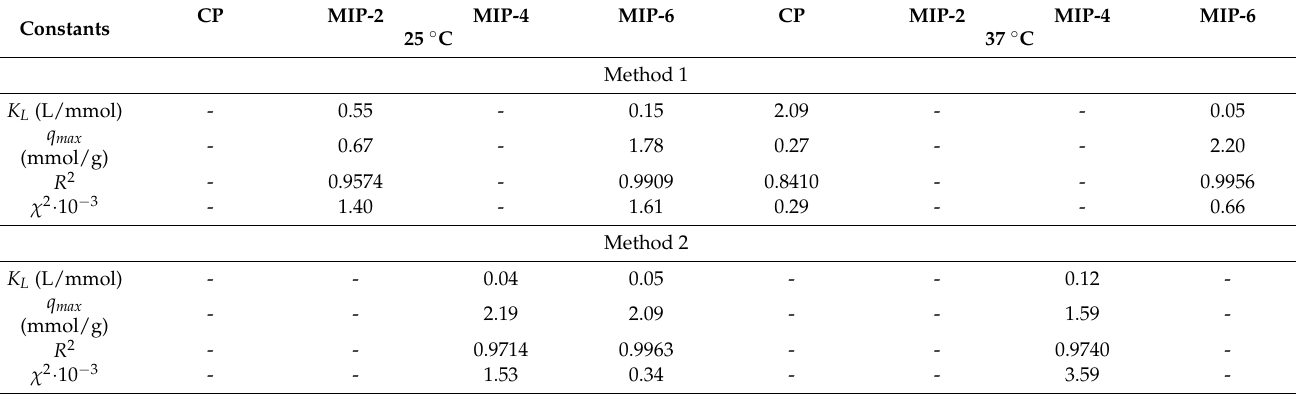
Table 3. Sorption constants calculated using the Langmuir model isotherm by the nonlinear regression method (Method 1 and Method